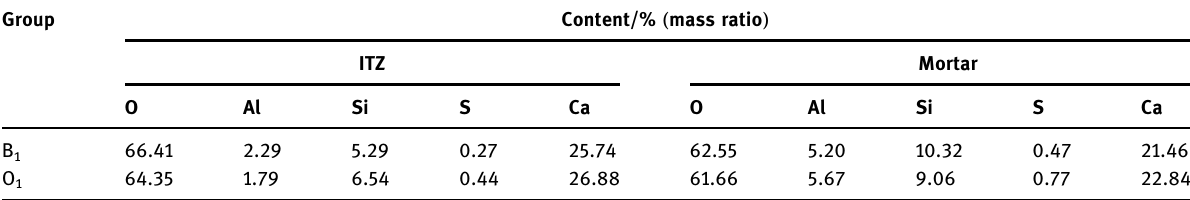
Table 7: Element composition of specimens from EDS analysis